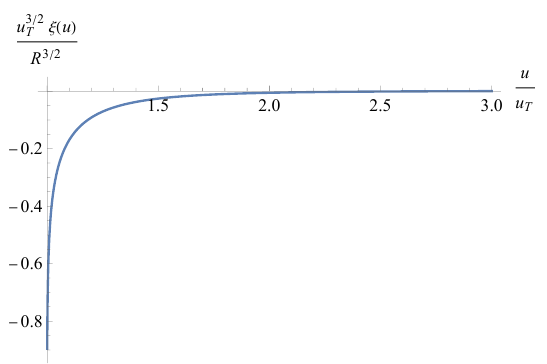
Figure 2 . The trailing solution of eq. (3.12) for v = 0 . 5 and u J = 3 u T . We have imposed ξ ( u J ) = 0 . Notice that ξ 0 ( u ) 6 = 0 despite what one could guess from the J